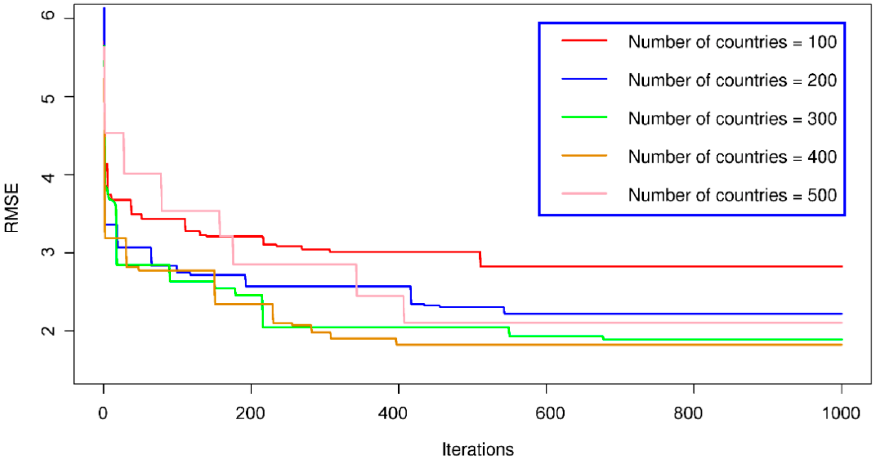
Figure 14. Imperialist competitive algorithm (ICA)-ANN performance for estimating HL of EEB systems in the training process.